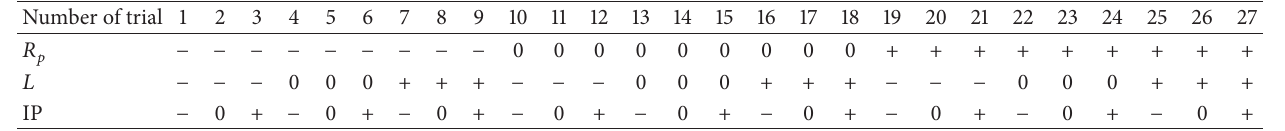
Table 3: Experimental